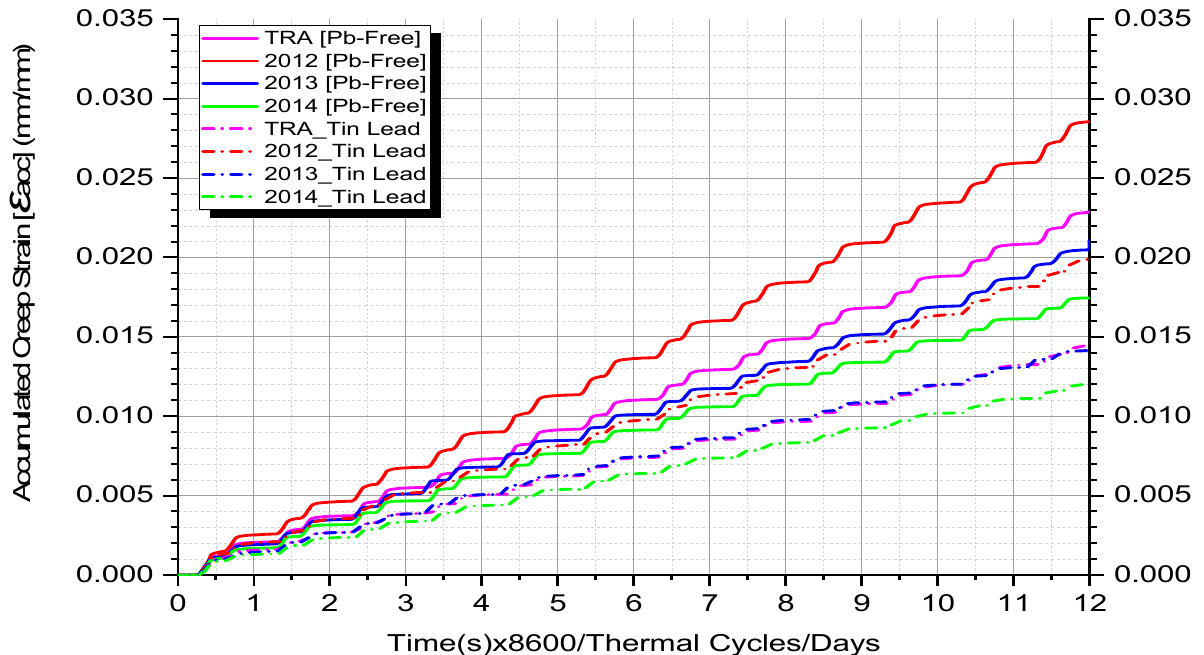
Figure 12. Accumulated creep strain response for PbSn and Pb-free solder for: TRA, 2012, 2013 and 2014 thermal cycles. After the third thermal cycle, however, variations in the cumulative creep strain response become more pronounced. The damage accumulation in the Pb-free solder for the 2013 and 2014 thermal cycles was slightly lower than during the TRA thermal period at the end of the 12 thermal cycles. The cumulative creep strain damage per cycle from the 2012 thermal cycle was found to be higher than that of the TRA thermal cycle, while using the same Pb-free solder interconnection. Similarly, for the 2013, 2014 and TRA periods, the cumulative creep damage response remained roughly equal up to the second thermal cycle with the SnPb solder interconnection. This trend continued with the 2013 and TRA cycles, which remain unchanged until the end of the 12 thermal cycles. However, the accumulated creep strain responses for the 2014 thermal cycle produced a relatively lower accumulated creep strain per cycle after the second thermal cycle and until the end of the 12 thermal cycles. This observation confirms what has been reported previously by Amalu and Ekere [41], who observed that, for a given thermal loading cycle, more than three thermal cycles are required to effectively assess creep damage in solders. Fewer than four thermal cycles may generate misleading results. It was observed further that the 2012 thermal cycle generated a relatively higher creep strain damage per cycle in the SnPb solder interconnection. The results from the accumulated creep strain show that the fatigue life of Pb-free solder interconnections is expected to be relatively lower as compared with SnPb solder interconnects at the test site. However, Syed [37] observed that the accumulated creep strain displays sensitivity to the type of constitutive equation used in modeling the behavior of the solder joint. Additionally, the accumulated creep strain is unable to capture damage resulting from low-temperature dwells effectively. On